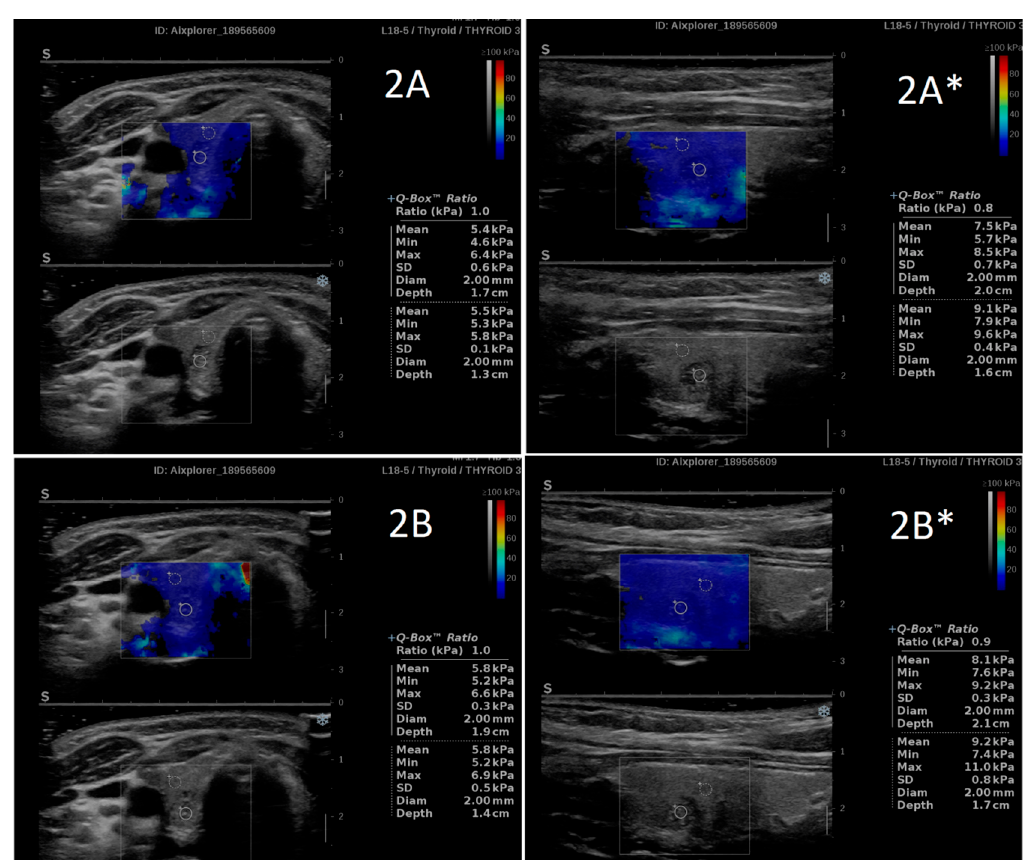
Figure 2. An example of the SWS and SWR results obtained by two independent researchers (( A , B ) Patient 2). A high similarity is clearly visible for both the SWS and SWR values. * Longitudinal plane imaging.